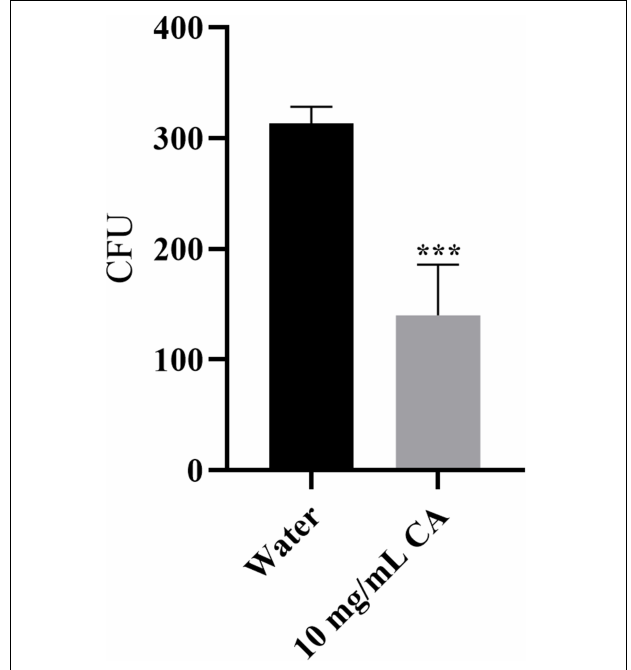
FIGURE 8 | The growth inhibition effect of CA on Y. enterocolitica in